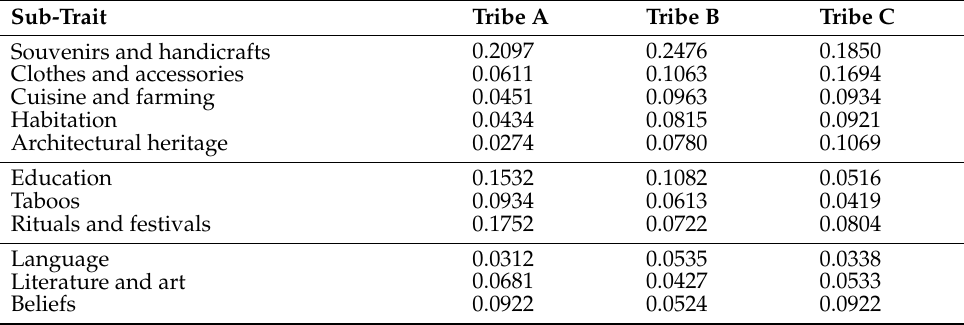
Table 4. The final priority order of sub-traits of the three tribes (weights). Sub-Trait Tribe